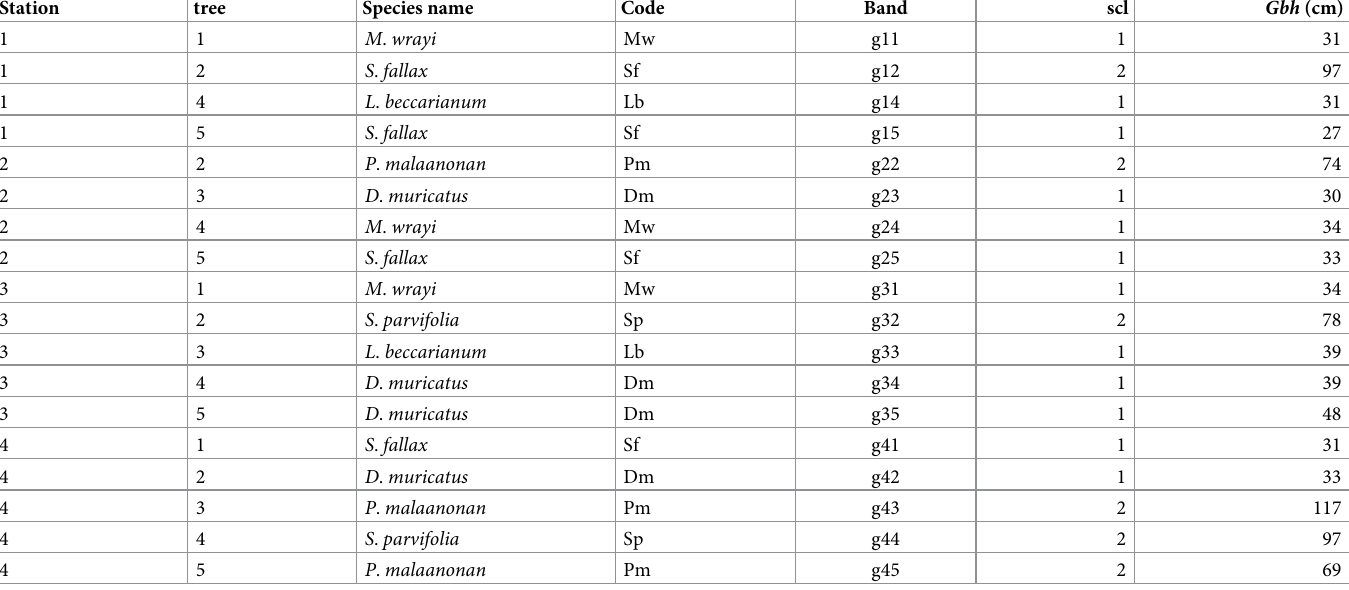
Dendroband records on trees and SMP-values each spanned slightly different times for the four stations, and within stations there were differing periods of missing days. All data were first matched to a common time frame of 1614 days (48 half-hour points within each day) between 01.03.2007 and 31.07.2011 (Fig 2). If an incidental or consecutive pair of values was missing, they were substituted by the means of values immediately before and after them. Daily means, of girth (cm) for each of the n = 20 trees, and of SMP (kPa) for the three or four Table 2. The 18 selected trees and their electronic bands (eDDS), with species names and codes, sizes ( gbh , cm) at start of recording (March 2007) and correspond- ing size classes ( scl ). Two of the original 20 trees could not be used (g13 and g21: see main text). Further details and covariables are given in Table A in S1 Appendix. Station